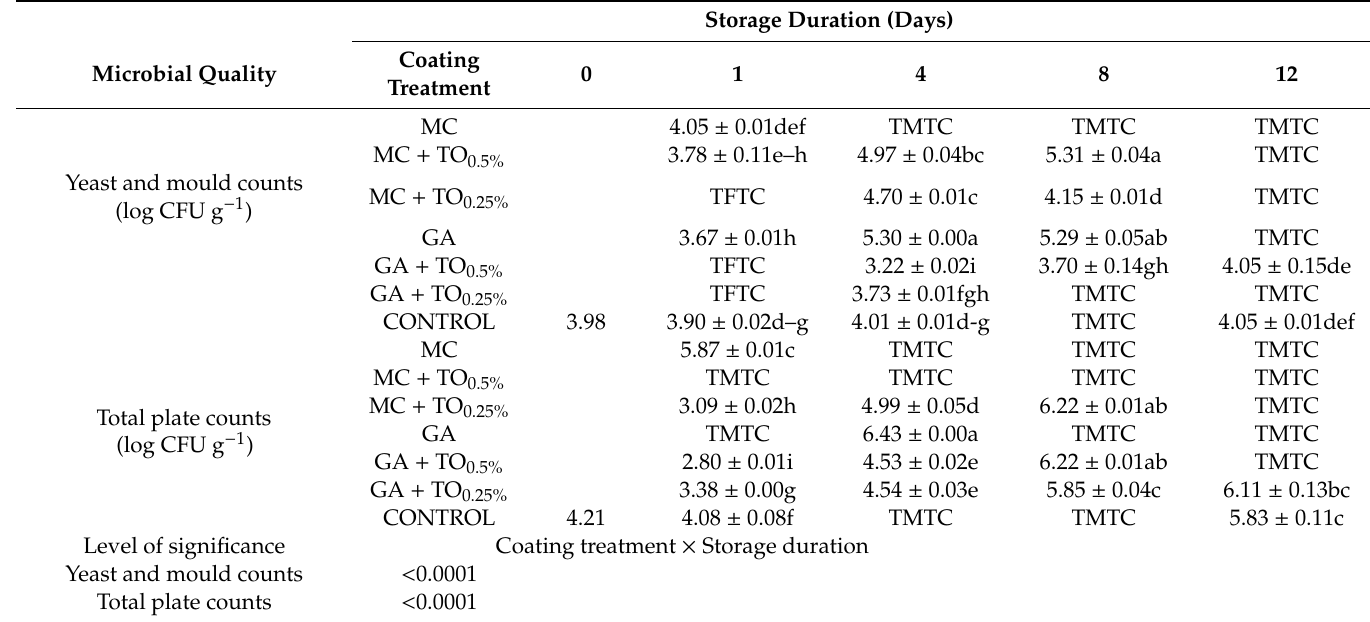
Table 2. E ff ects of gum arabic and methyl cellulose coating emulsions containing thyme oil (0.5% and 0.25%) on yeast and mould counts (log CFU g − 1 ) and total